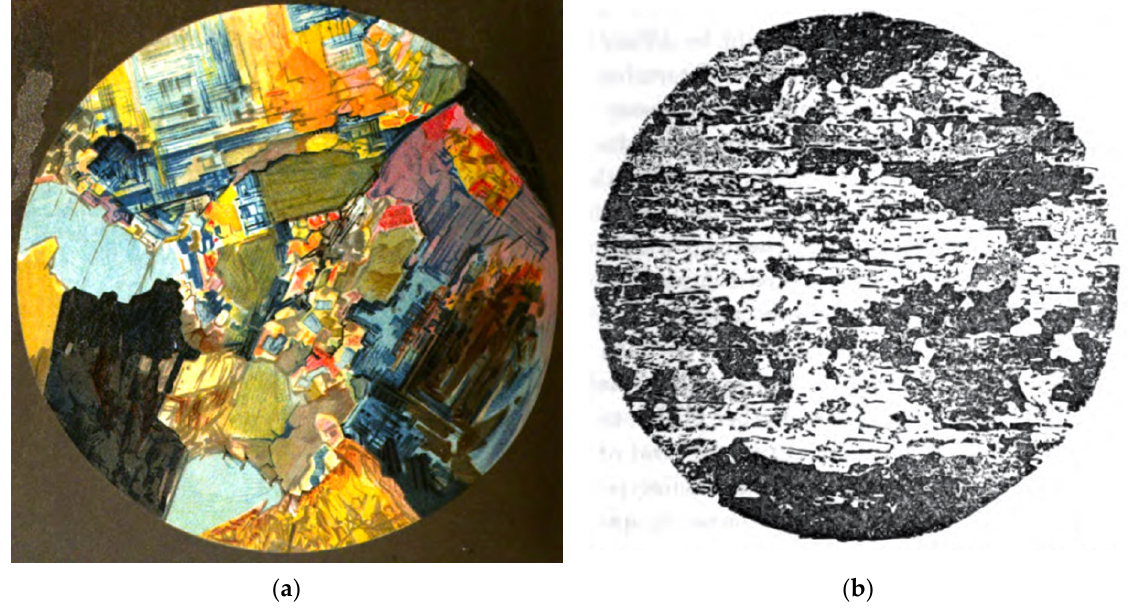
Figure 4. ( a ) Colour plate reproduction of a painting of the granular structure of granite observed in 1883 using polarized light microscopy. No scale bar or magnification was given. From [51]. ( b ) Optical micrograph of the microstructure of acid-etched armour steel published by Bayles in 1883 [52]. This photograph was originally taken by Sorby and presented at a lecture he gave to the Sheffield Literary and Philosophical Society [53]. No magnification or scale bar was included.